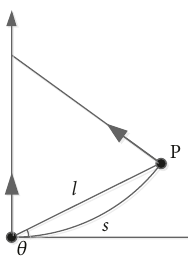
Figure 7: Votes cast by a stick tensor at the origin O